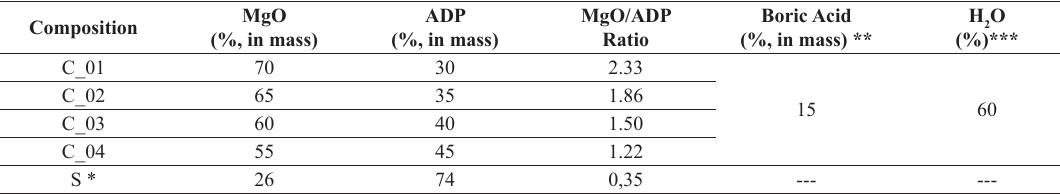
H PO ratio in magnesium phosphate cement compositions. 4 2 4